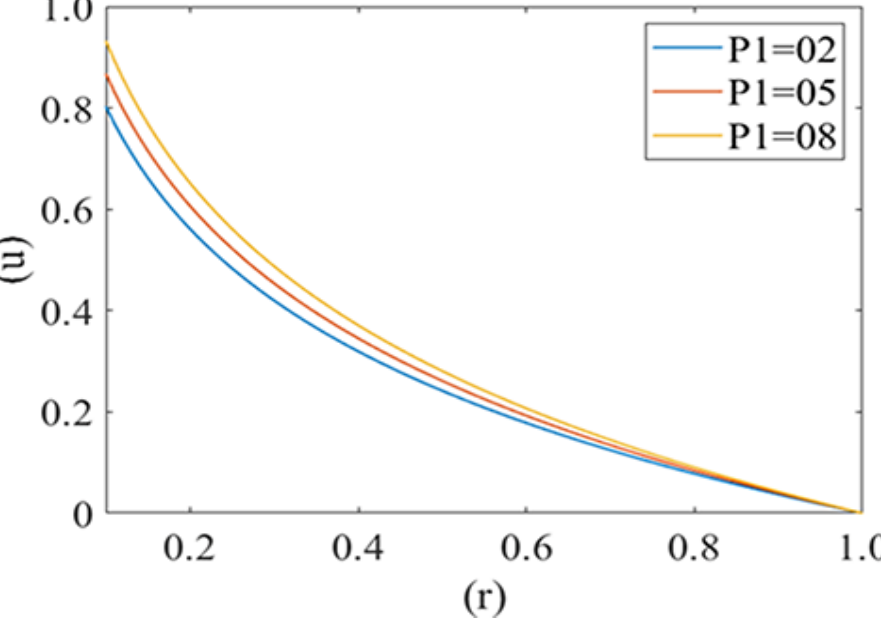
Figure 5. Variation of axial velocity component ( u ) of the plasma film with a deformed cell radius ( r ) in microcirculation with a change in mean pressure ( P1 ) in plasma with Re = 0.25, P2 = 2. Figure 6 represents the variation in the mean pressure gradient ( P1 ) on the red blood cell with respect to the height of the lubricating film ( h(x) ) of plasma for different values of beta cell compliance (i.e., β = 0.2, 0.4, 0.6). It is observed that P1 is decreasing (Very minutely) with an increase in